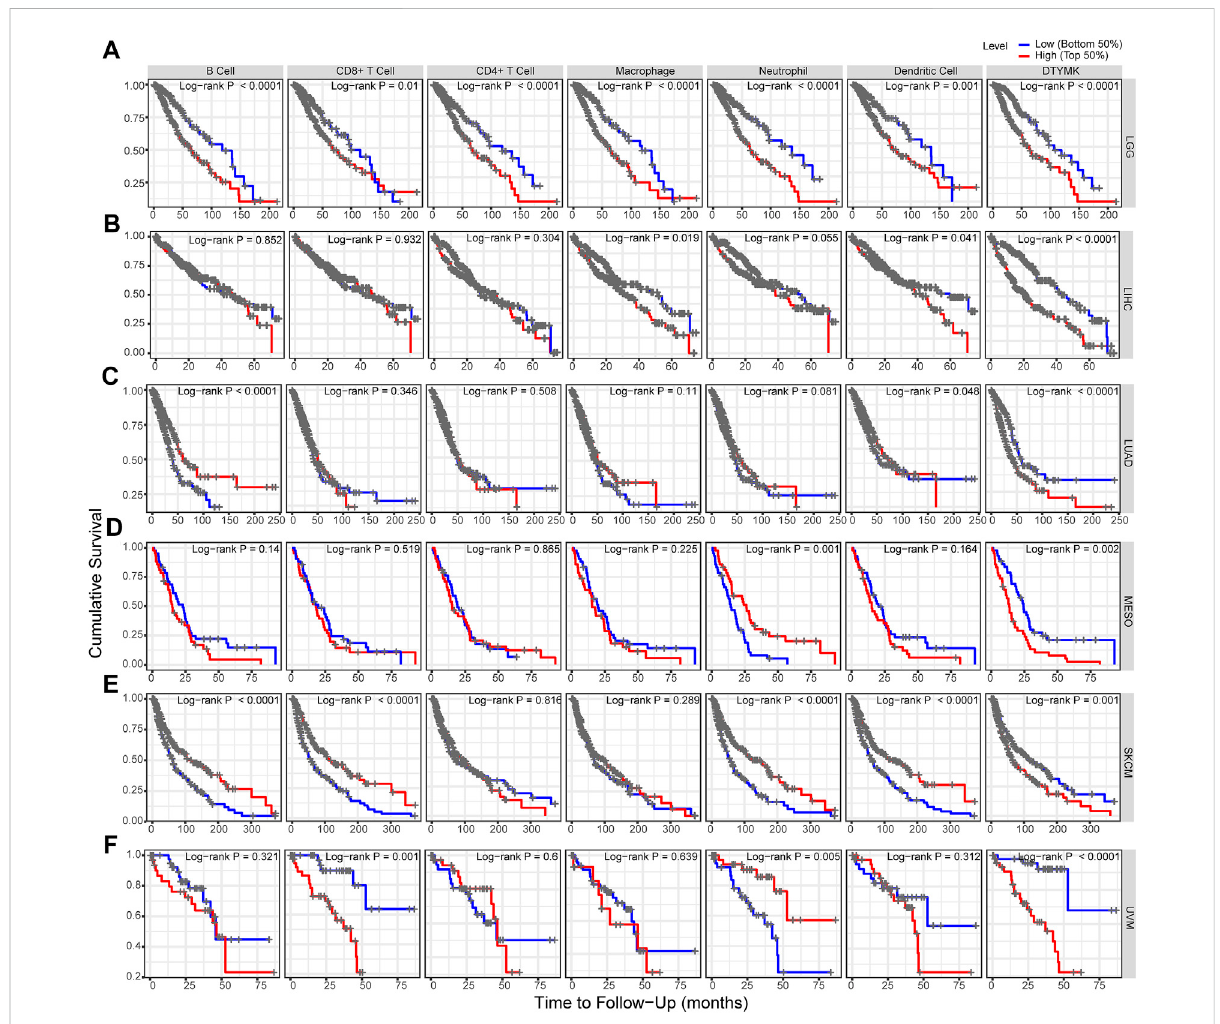
FIGURE 13 DTYMK regulates tumor-in fi ltrating immune cells level to affect prognosis. (A) High expression of B cells, CD8 + T cells, CD4 + T cells, macrophage, neutrophil, and dendritic cell was correlated with poor prognosis in LGG. (B) High expression of macrophage and dendritic cell was correlated with poor prognosis in LIHC. (C) Low expression of B cell and dendritic cells was correlated with poor prognosis in LUAD. (D) Low expression of neutrophil cells predicted poor prognosis in MESO. (E) Low expression of B cells, CD8 + T cells, neutrophil, and dendritic cells predicted poor prognosis in SKCM. (F) High expression of CD8 + T cells and neutrophil cells was correlated with poor prognosis in